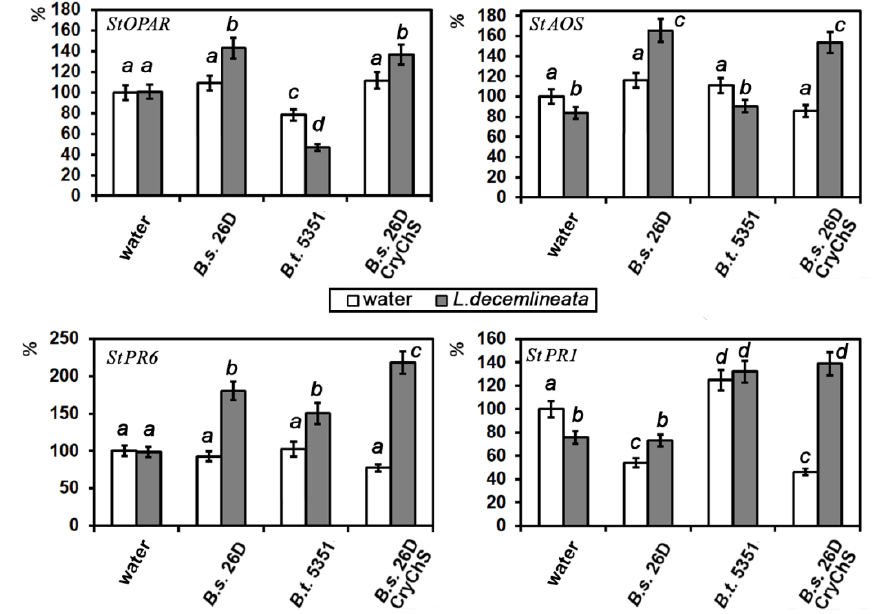
Figure 6. The e ff ect of Bacillus strains on transcriptional activity of StPR6, StPR1, StAOS , and StOPAR genes in potato plants after 24 h post damage caused by larvae of L. decemlineata . Data presented as mean values ± standard error, values labeled by the same character are not significantly di ff erent from each other according to Student’s test P <